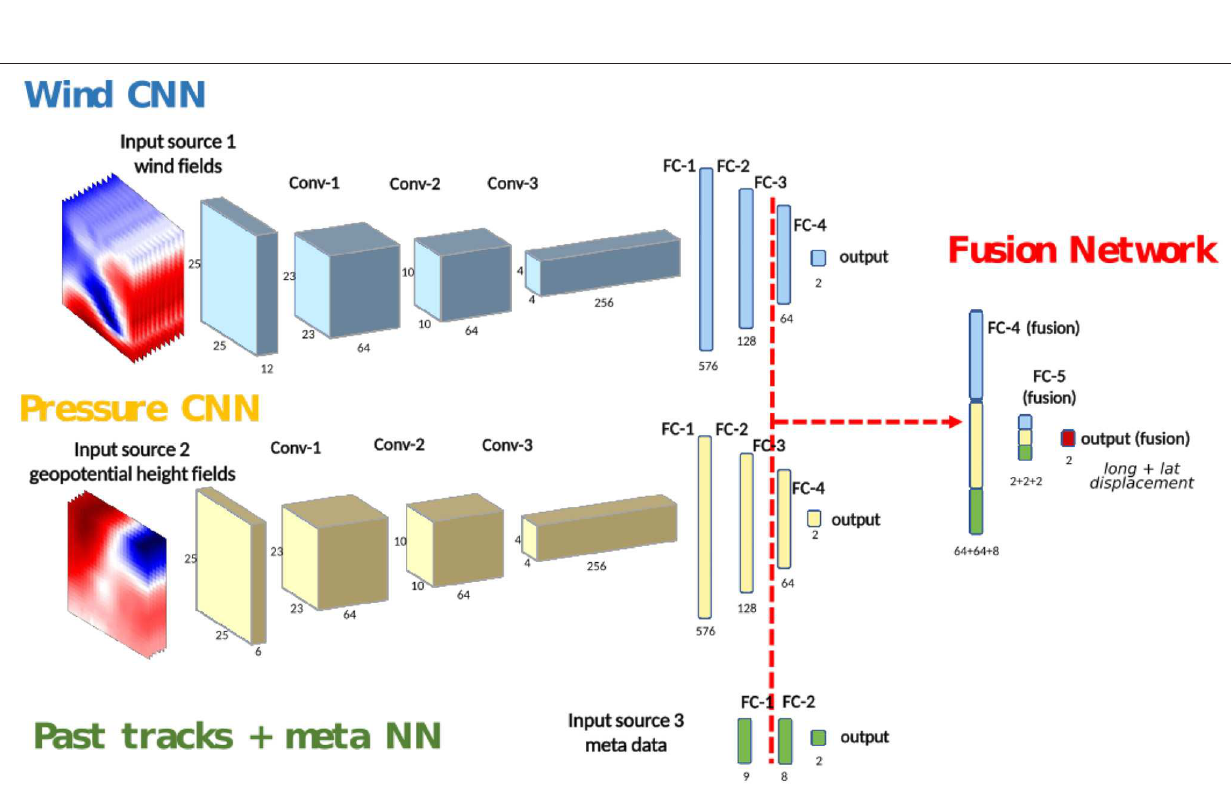
Frontiers in Big Data |